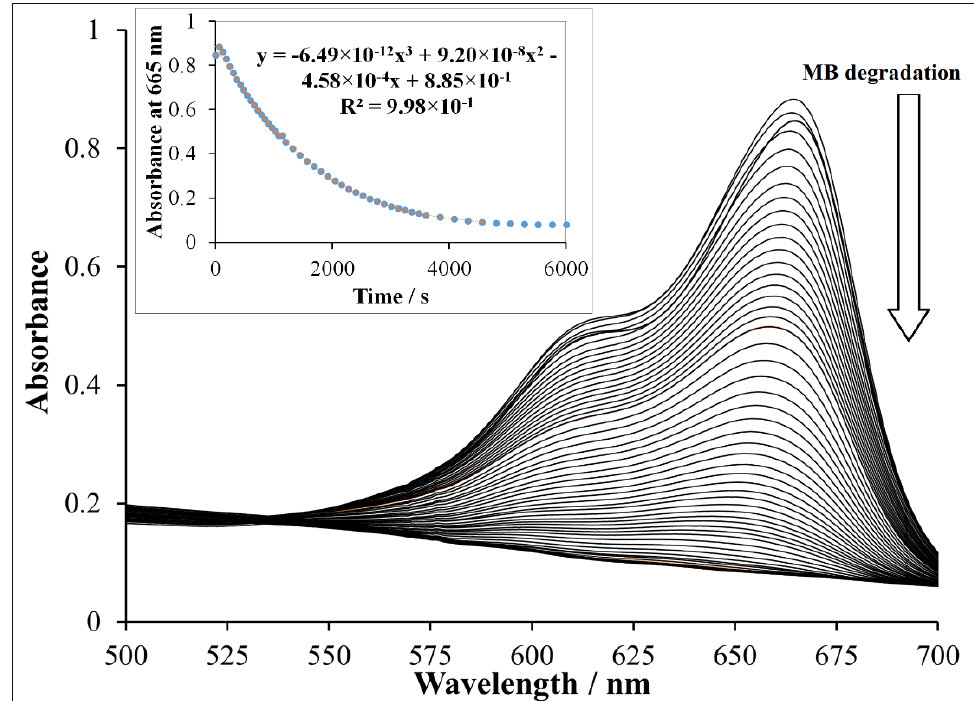
Figure 6. Methylene blue degradation using doped ferrite NP-3. Experimental conditions: concentration of NP-3 = 400 mg/L, concentration of methylene blue (MB) = 1.5 × 10 −5 mol/L, concentration of H 2 O 2 = 1.76 × 10 −1 mol/L, and initial pH = 7.5.